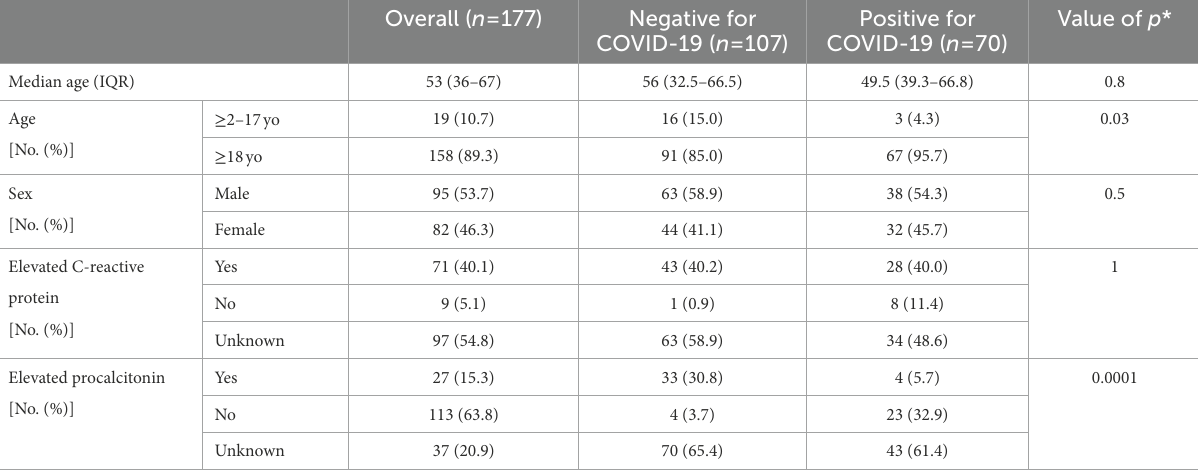
TABLE 1 Demographic, clinical, and laboratory characteristics of the individuals included in the